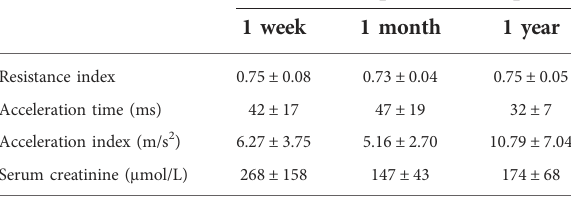
TABLE 1 Pre-selected Doppler ultrasound and laboratory parameters at 1 week, 1 month, and 1 year follow-up examinations after kidney transplantation.